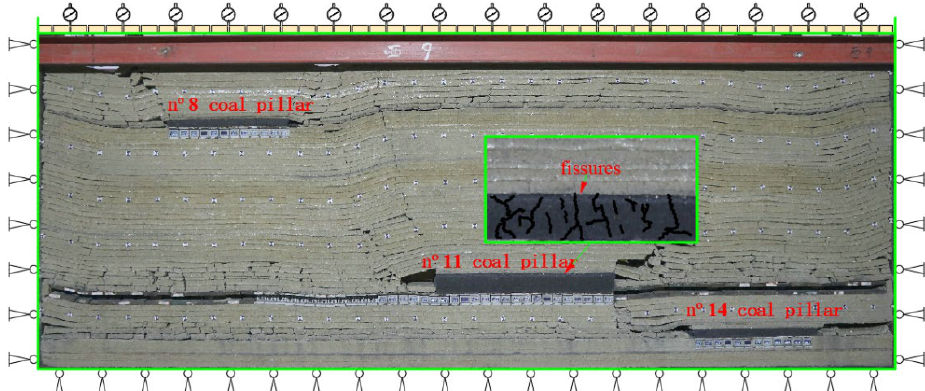
Figure 7. Coal pillar deformation after excavation of each coal